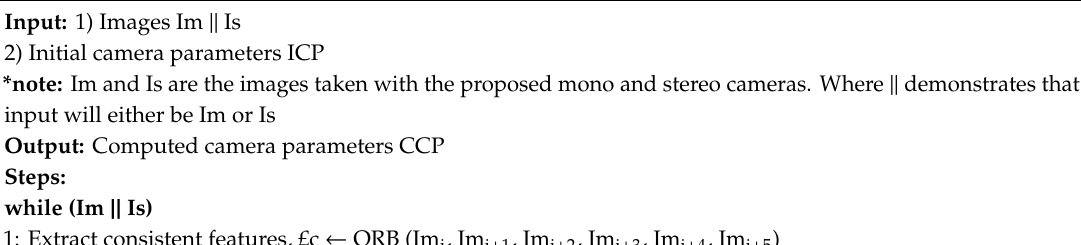
Algorithm 1 Camera Calibration Steps